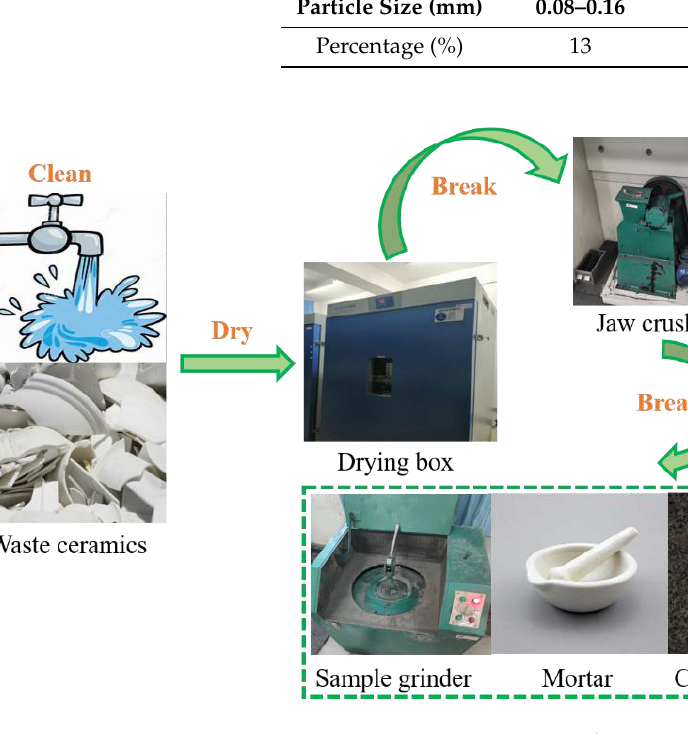
Figure 1. Industrial sulfur, modifier, and fly ash ( a ) Industrial sulfur; ( b ) DCPD; ( c ) Fly ash. Table 1. Particle size and its proportion.